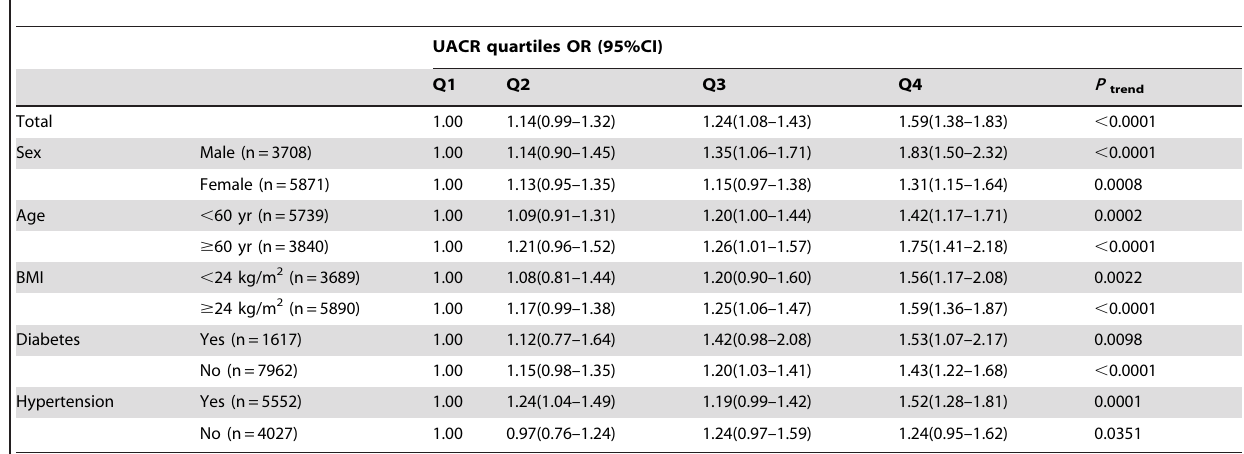
Table 3. Elevated UACR quartiles associated with the prevalence of MetS in total and stratified population.